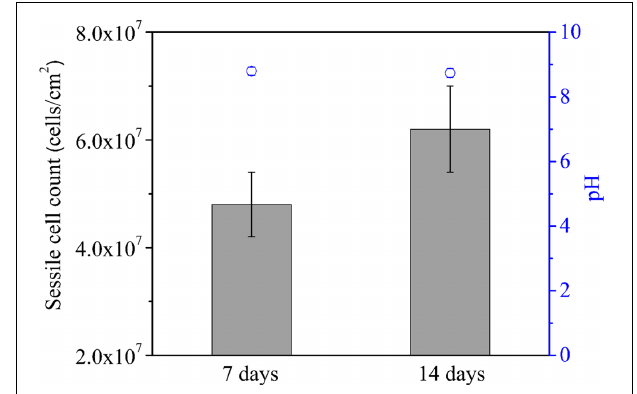
FIGURE 1 | Sessile cell counts (bars) on the coupon surface and pH values (circles) of the culture medium after 7 and 14 days of incubation. Scatter bands are standard deviations of 4 independent